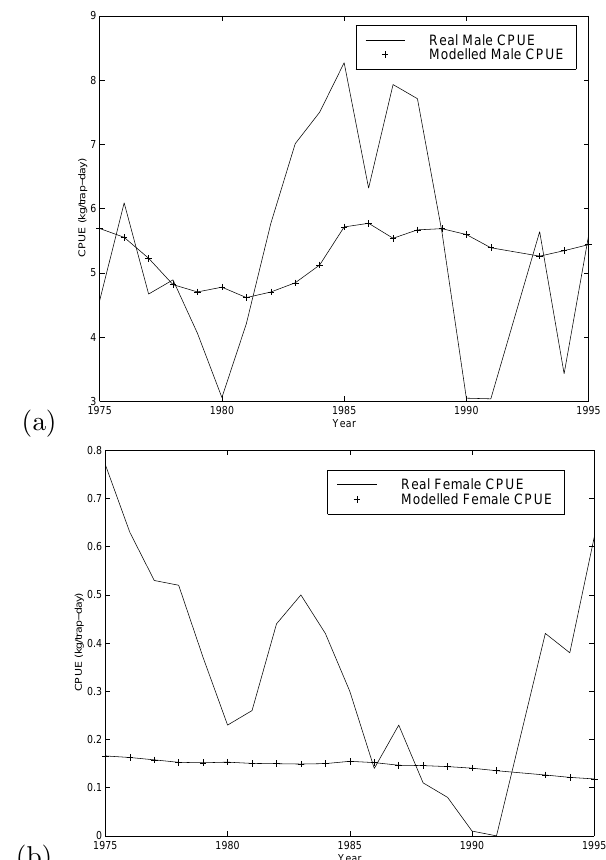
Figure 8: (a) Male modelled CPUE fit to observed data for the Cape Rock Lobster. (b) Female modelled CPUE fit to observed data for the Cape Rock